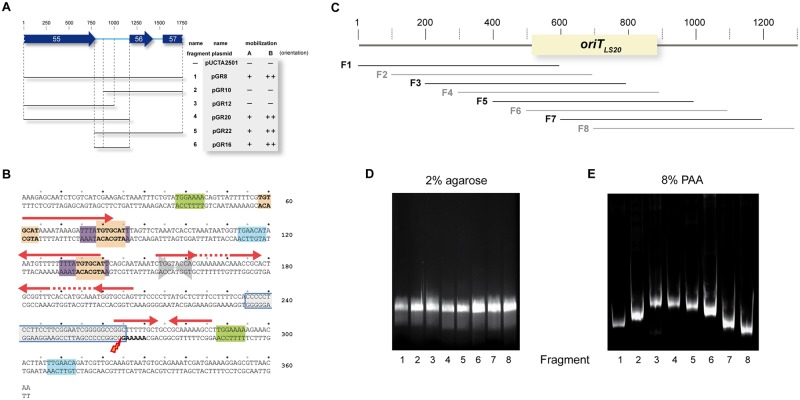
Determination and characteristics of oriTLS20.(A) Schematic overview of pLS20cat regions analyzed for the presence of a functional oriT region. The corresponding pLS20cat region and position of genes 55, 56 and 57 are presented on the top. Numbers correspond to length in base pairs. The regions cloned are indicated by horizontal bars. The names of the fragments and the plasmids, and their ability to be mobilized are indicated at the right. “A” and “B” correspond to the orientation of the cloned fragment. -, + and ++: mobilization frequencies <10−7, in the order of 10−5, and 10−4, respectively. (B) Features of the oriTLS20 region. The sequence of the 362 bp oriTLS20 region is presented along with identified features. Inverted repeated sequences are indicated with red arrows. Identical or nearly identical direct repeated sequences are boxed in green, orange or purple. Note that the sequence with consensus 5´-TGTGCAT´-3 is present three times. The palindromic sequence 5´-TGGTACCA-3´ is indicated with two converging arrowheads. The 30-bp region with a GC-content of 73% is highlighted with a blue-lined box. Numbering of the fragment is given on the right. The determined nic site is indicated with a lightning symbol. (C) Schematic representation of the 1,300 bp pLS20cat region containing oriTLS20 (blue box) studied for the presence of a static bent. The lower part indicates the positions of the 600 bp DNA fragments F1 to F8 with respect to oriTLS20, and which were subjected to electrophoresis in gels of 2% agarose (D) or 8% native PAA (E). After electrophoresis, the agarose and PAA gels were stained with ethidium bromide.